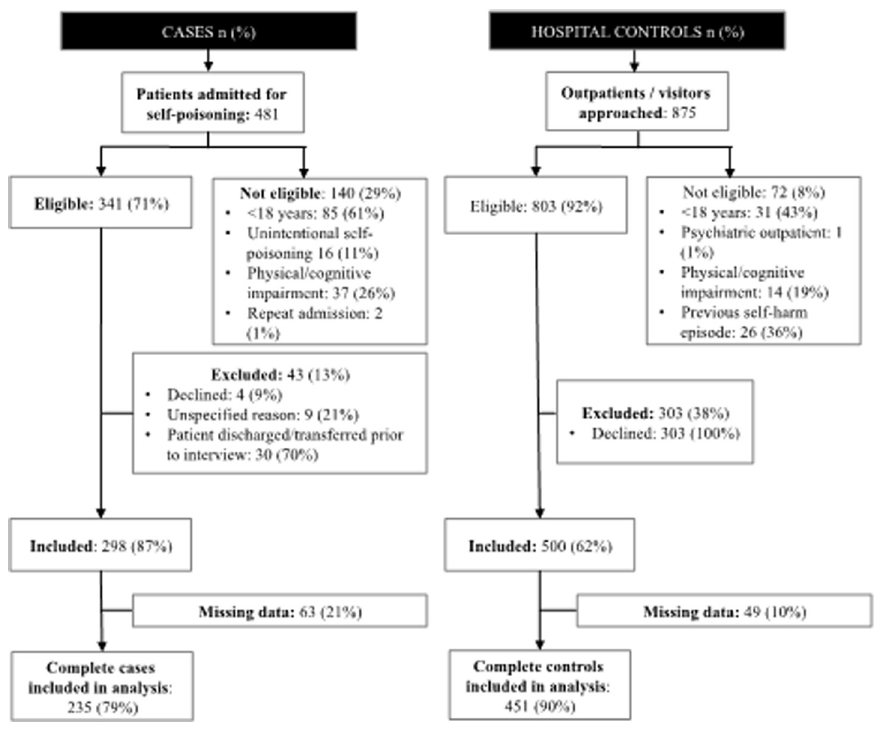
Fig 2. Participant recruitment for cases, and hospital